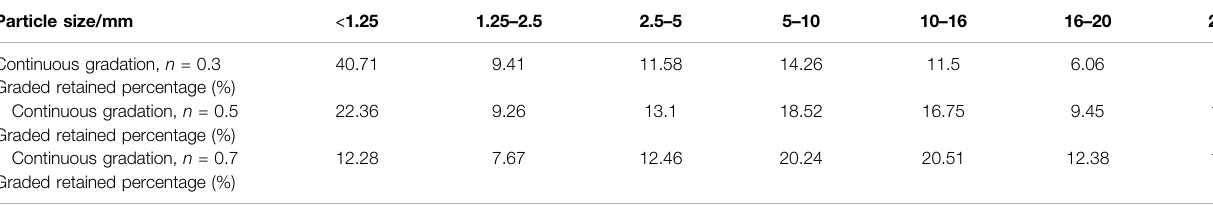
TABLE 6 | Laboratory gradation table of continuous graded fi lling gangue.